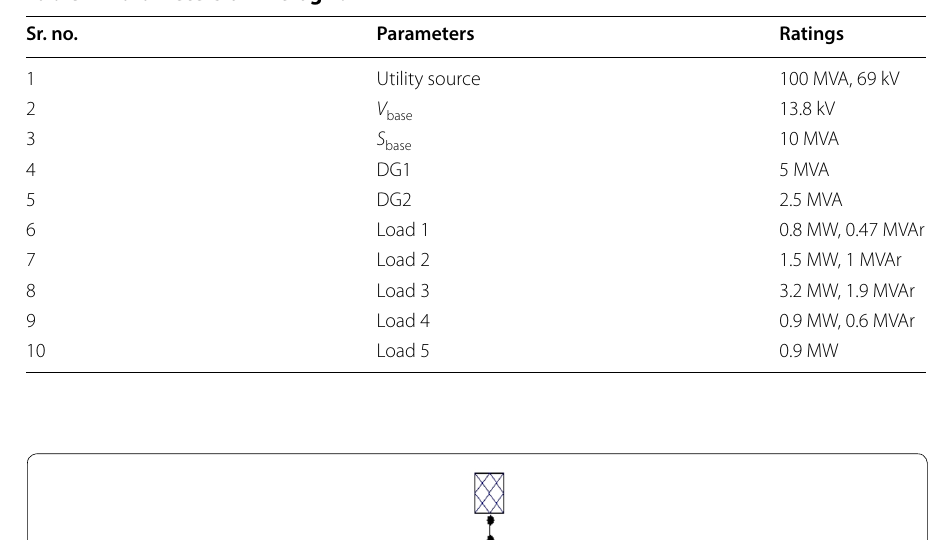
Table 4 Parameters of microgrid